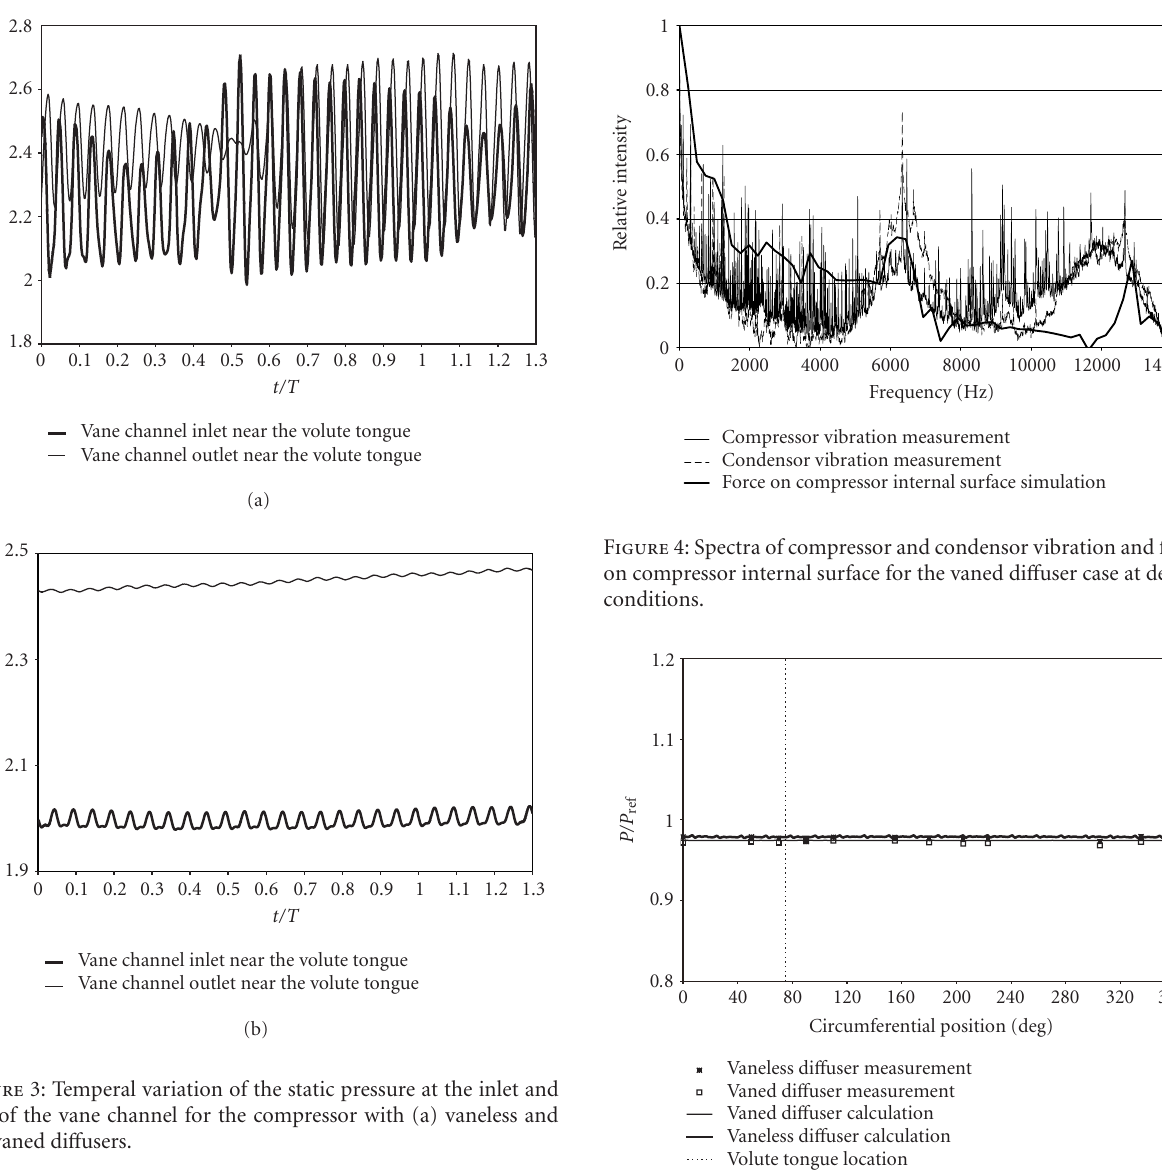
Figure 5: Static pressure at the inlet of the impeller for the vaneless and vaned di ff